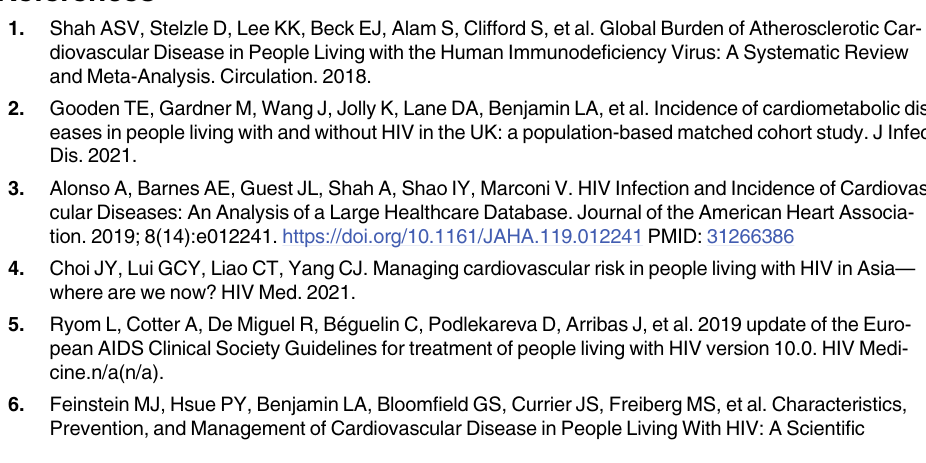
S3 Fig. Machine-learning analysis for AUC comparison between different models includ- ing risk prediction score and retinal information in predicting obstructive coronary artery disease. (Model 1: Inclusion of cardiovascular risk prediction score with the highest AUC only; Model 2: Inclusion of retinal information only; Model 3: Inclusion of cardiovascular risk prediction score and retinal